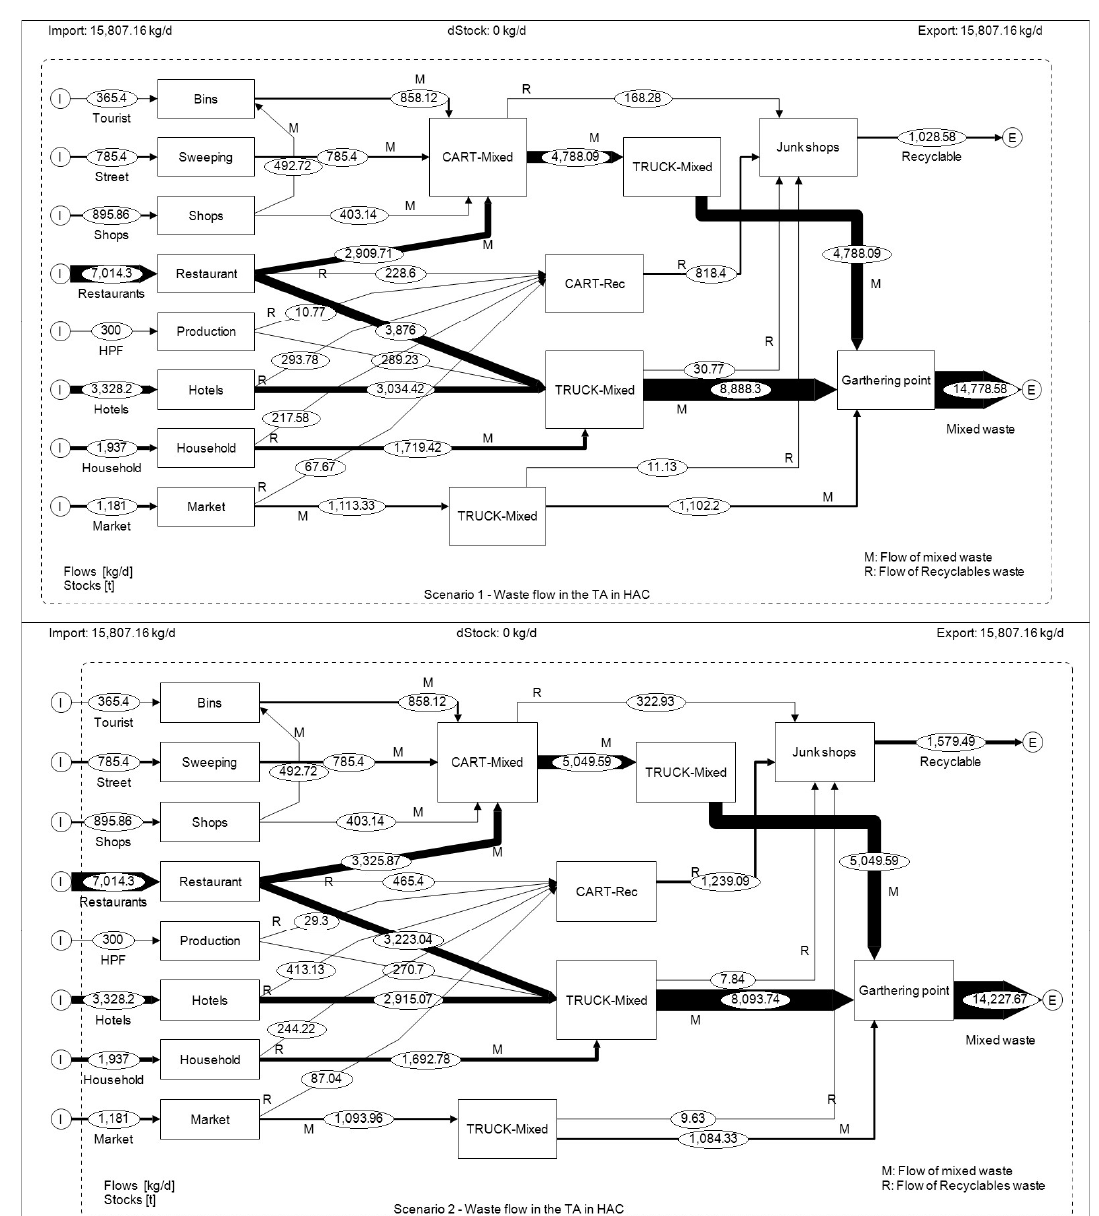
Fig. 3: Waste flow of S1 and S2